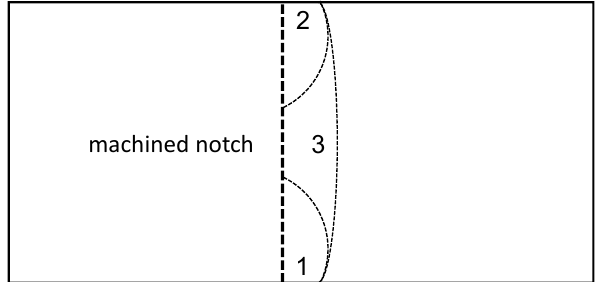
Figure 3. Visualization of novel notching technique for pre-crack insertion. 1, 2 and 3 denote the sequence of crack